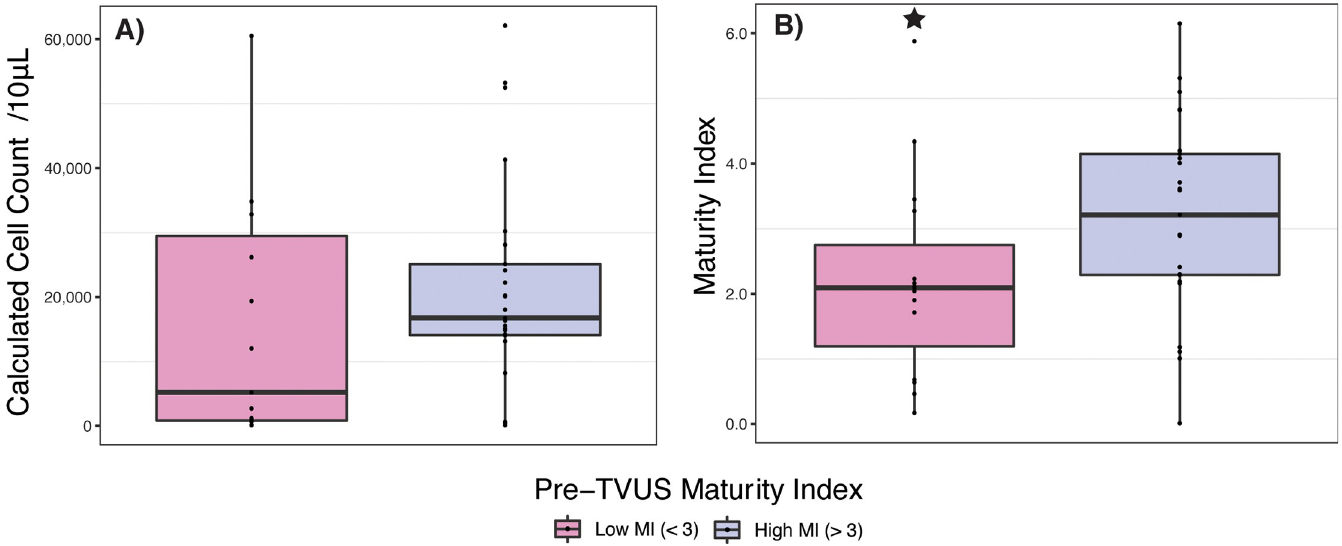
Fig 3. Stars represent significant difference between low MI and high MI samples. A. Cell-count per 10 μ L CVF in samples taken within two weeks of TVUS (W2-post-TVUS) with lubricant exposure, comparing women with a pre-TVUS maturity index < 3 and women with a pre-TVUS maturity index > 3. B. Maturity index of samples taken within two weeks of TVUS (W2-post-TVUS) with lubricant exposure, comparing women with a pre-TVUS maturity index < 3 and women with a pre- TVUS maturity index > 3.